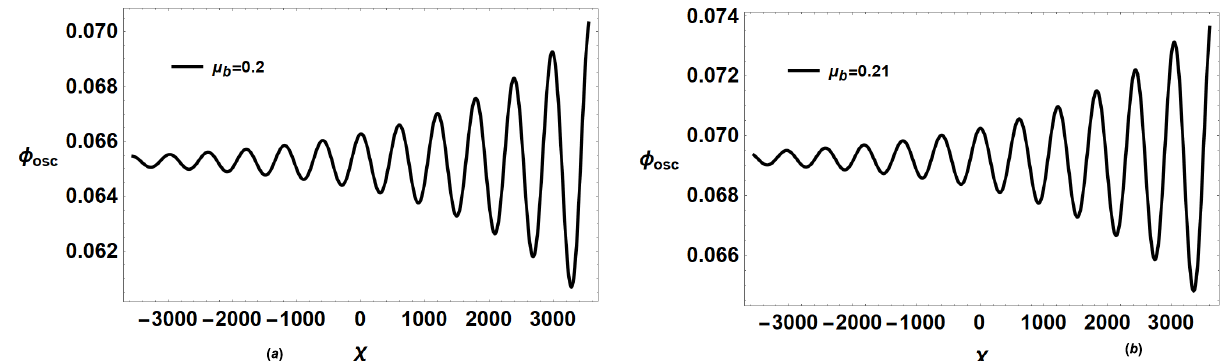
Figure 4. (Color online) Variation of oscillatory shock waves for different values of ion-beam density ratio ( µ b ) ( a ) µ b = 0.2